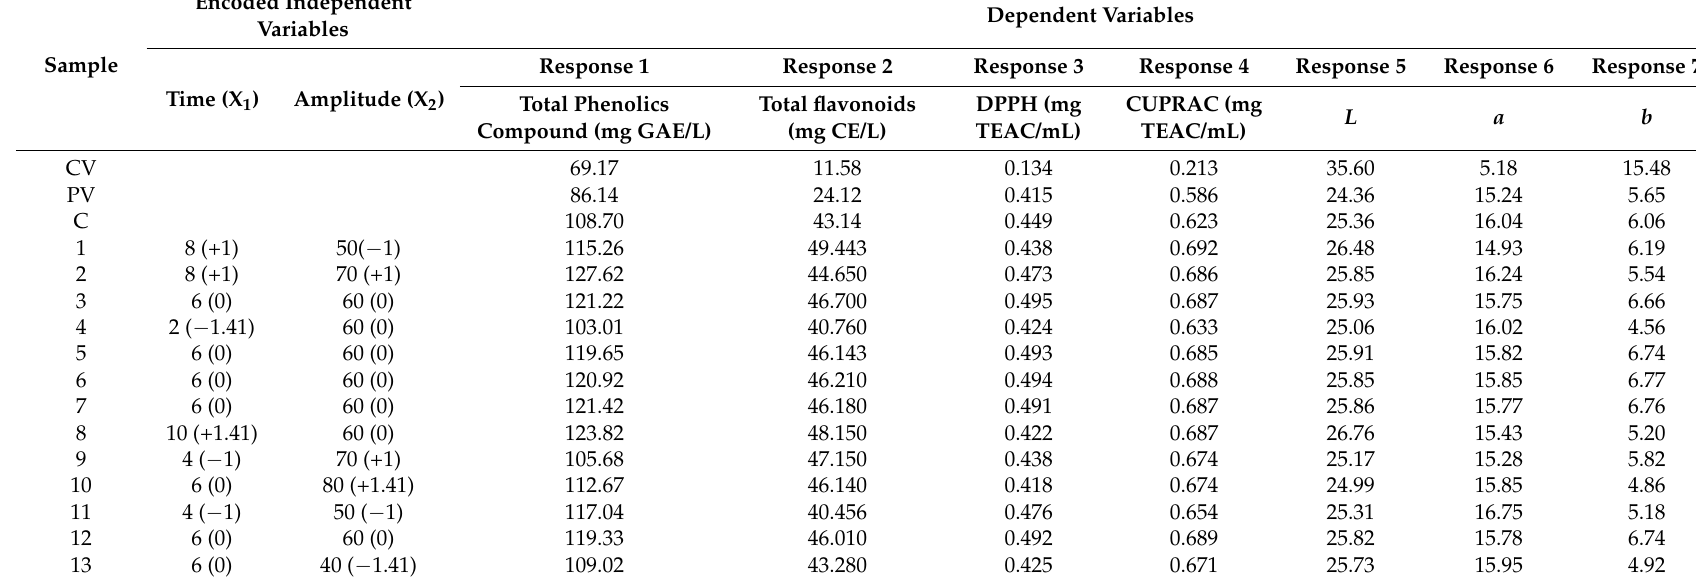
Table 2. Measured responses used in experimental design for